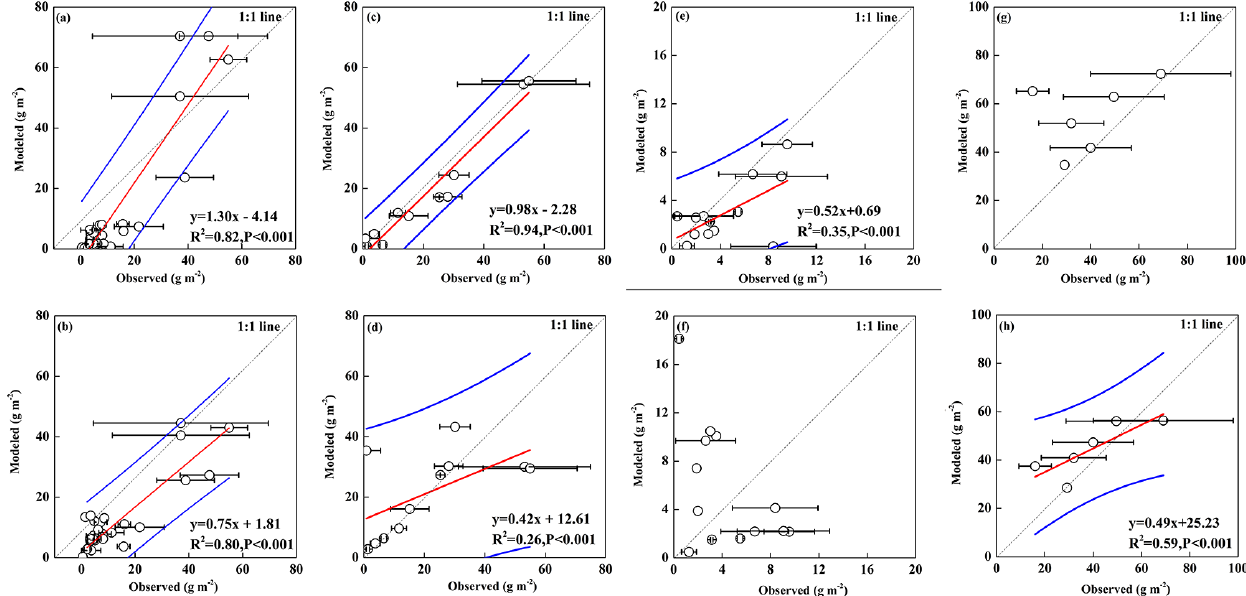
Figure 3. Regression of simulated against observed total amount of seasonal/annual CH 4 emissions from North American wetland sites by CH4MOD wetland (a) and TEM (b) , from Asian wetland sites by CH4MOD wetland (c) and TEM (d) , from European wetland sites by CH4MOD wetland (e) and TEM (f) , and from South American and African wetland sites by CH4MOD wetland (g) and TEM (h) . The horizontal bars are the standard errors from the sampling replicates at the wetland site. The blue line is the prediction correspondence. The dashed line is the 1:1 line.